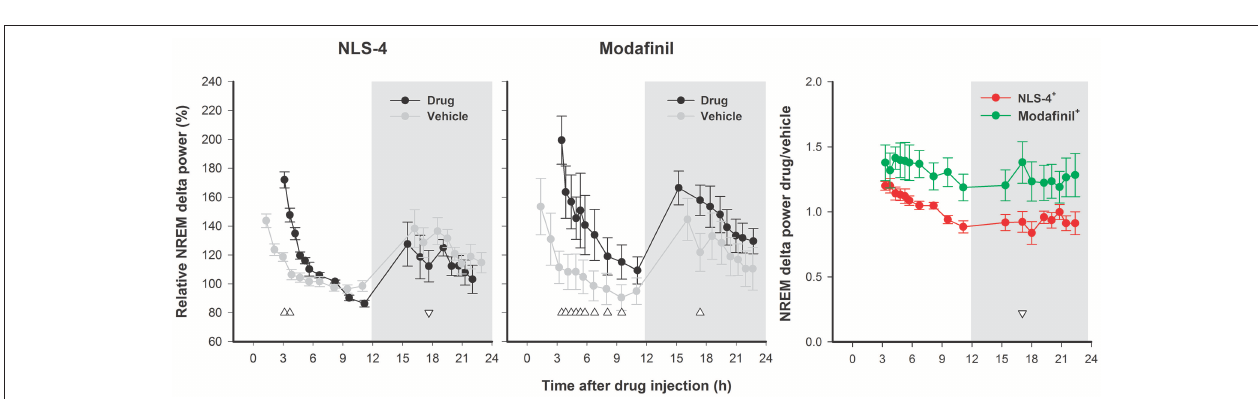
FIGURE 4 | Time course of slow-wave (delta) activity (0.75–4Hz) during NREM sleep following drug-induced wakefulness. Delta power is increased during the first 2 time intervals of sleep after NLS-4 [2-way repeated measures ANOVA, “treatment” p > 0.9, F (1, 5) = 0.01, “hour” p < 0.001, F (17, 85) = 11.79, interaction p < 0.001, F (17, 85) = 5.04] and during the first 9 time intervals after modafinil administration [2-way repeated measures ANOVA, “treatment” p < 0.05, F (1, 6) = 9.35, “hour” p < 0.001, F (17, 102) = 17.88, interaction p < 0.05, F (17, 102) = 2.04]. Comparison between drugs indicates an overall increased spectral power after modafinil administration [2-way ANOVA, “drug” p < 0.05, F (1, 11) = 5.23, “hour” p < 0.001, F (17, 187) = 4.39, interaction p = ns, F (17, 187) = 0.93]. Upward and downward triangles indicate significant increase or decrease in delta power, respectively. Shaded areas indicate the dark period.